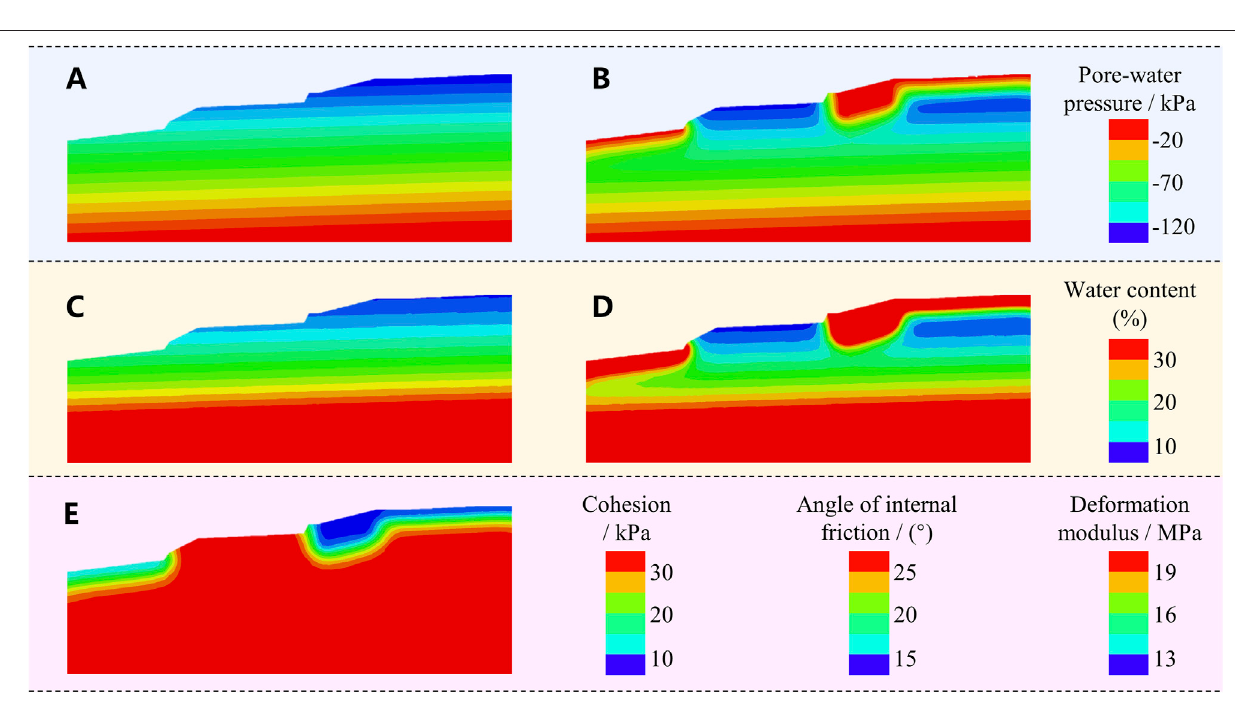
bulk unit weight of the loess, are fi tted based on the seepage Seepage-Coupled Stability Simulation .